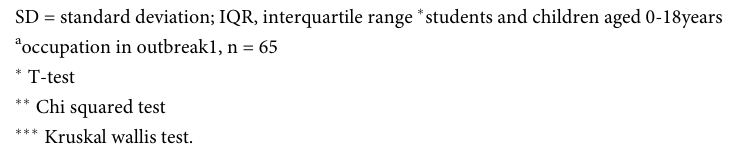
The weekly epidemiologic curve of confirmed and probable LF cases by Outbreak is shown in Fig 4 . The evolution of the two Outbreaks occurred at separate time periods, with peak inci- dence in epi week 8 (February) for Outbreak 1 and epi week 45 (October) for outbreak 2. The clinical features and laboratory findings associated with mortality are shown in S4 Table . The risk of mortality in the two outbreaks is distinctly different with a fatality of 29.9% in outbreak 1compared to 85.7% for outbreak 2 (p < 0.001). The presence of neurological fea- tures as well as abnormal laboratory tests were associated with higher mortality, which were more common in outbreak 2 than in outbreak 1. Patients with neurological features, had a Rel- ative Risk (RR) of dying of 8.5 compared to those without. No demographic variables were sig- nificantly associated with mortality: They are not displayed in the table. The odds and adjusted odds of mortality for a selection of variables that were considered important potential confounders, notably, days to presentation, occupation and location are